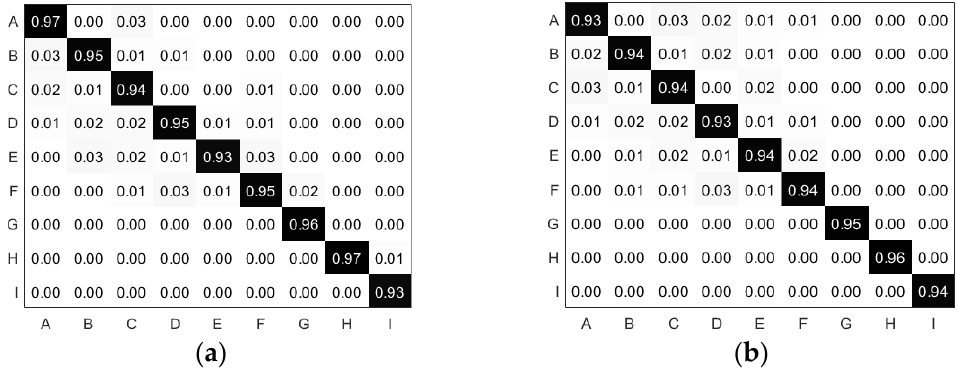
Figure 10. ( a ) Confusion matrix for each action test of the test for known persons. ( b ) Confusion matrix for each action test of the test for unknown persons.